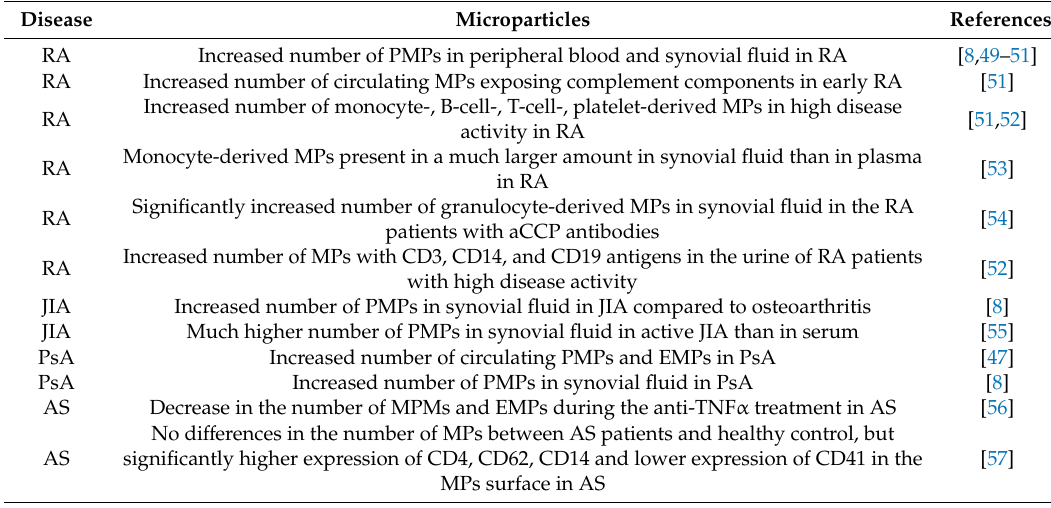
Table 2. Microparticles in blood and other biological fluids in inflammatory joint diseases. Disease